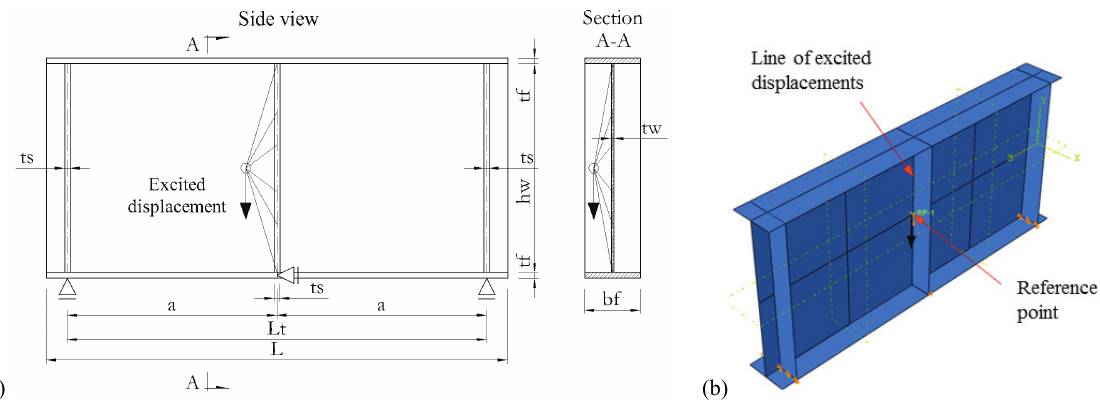
Fig. 4. Boundary conditions and geometric parameters of girder and graphic illustration of kinematic